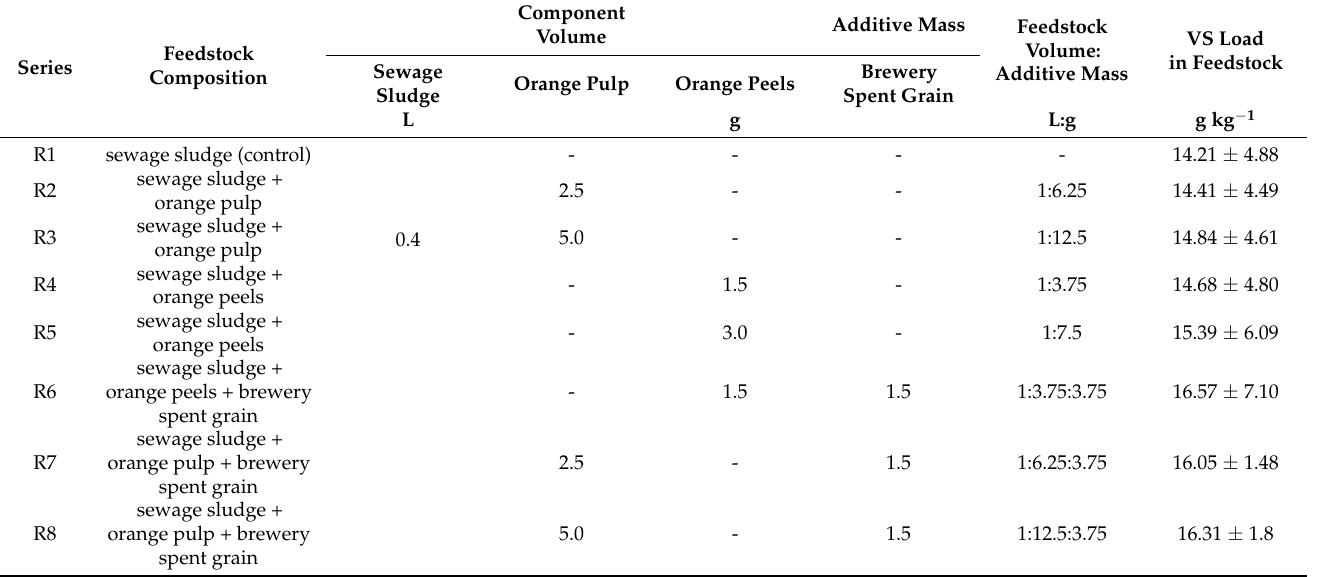
Table 1. Experimental